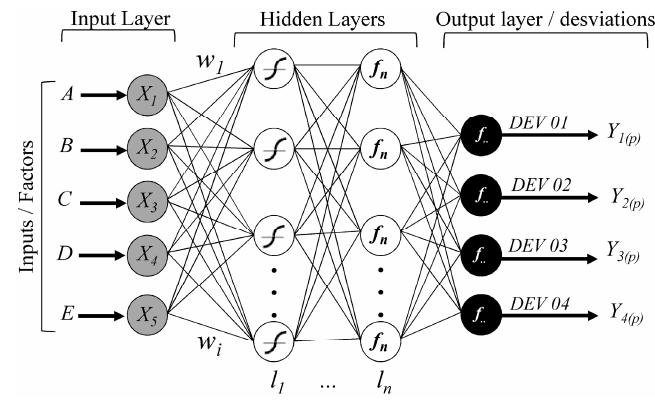
Figure 4. Neural network structure model developed for the tests.